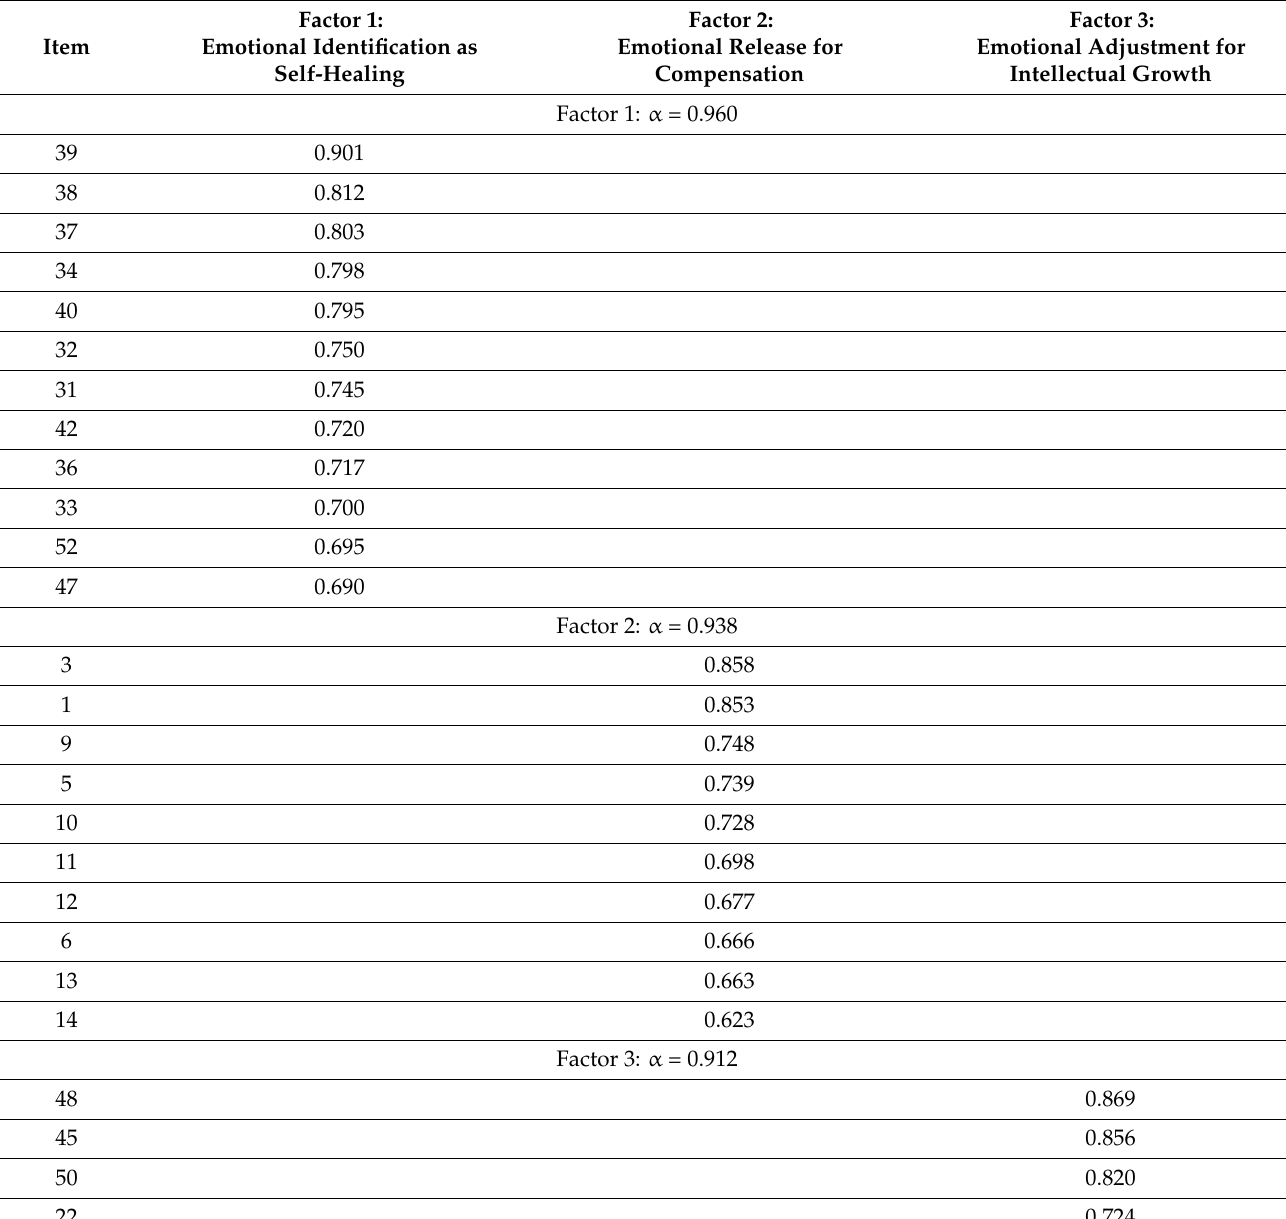
Table 1. Rotated factor loading and eigenvalues of the first version (29 items) for the